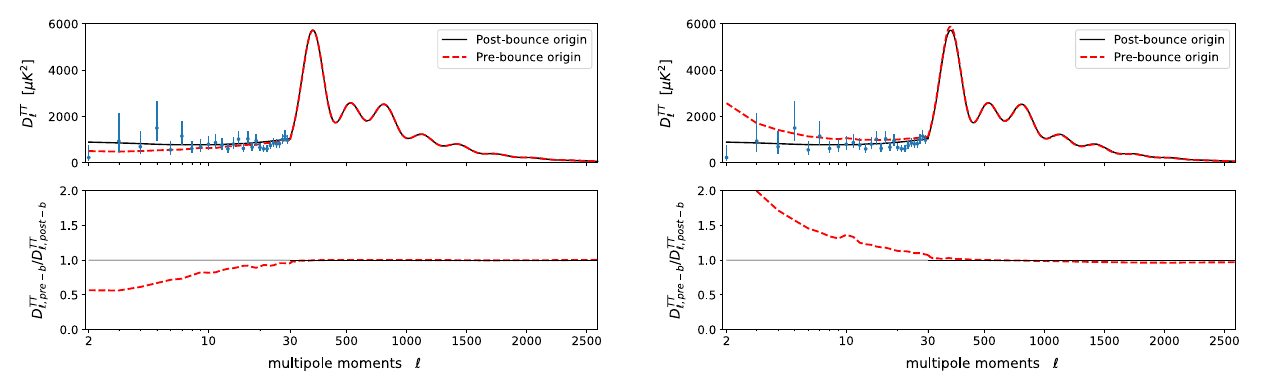
Fig. 10 Temperature angular power spectra D TT (cid:16) for a pre-bounce and for a post-bounce origin of structures, with background IC {− 0 . 467 , + 1 } ,andaquadraticpotential. Top: D TT indashedred,Planckdatainblue. Bottom: Ratioofthespectraindashed red